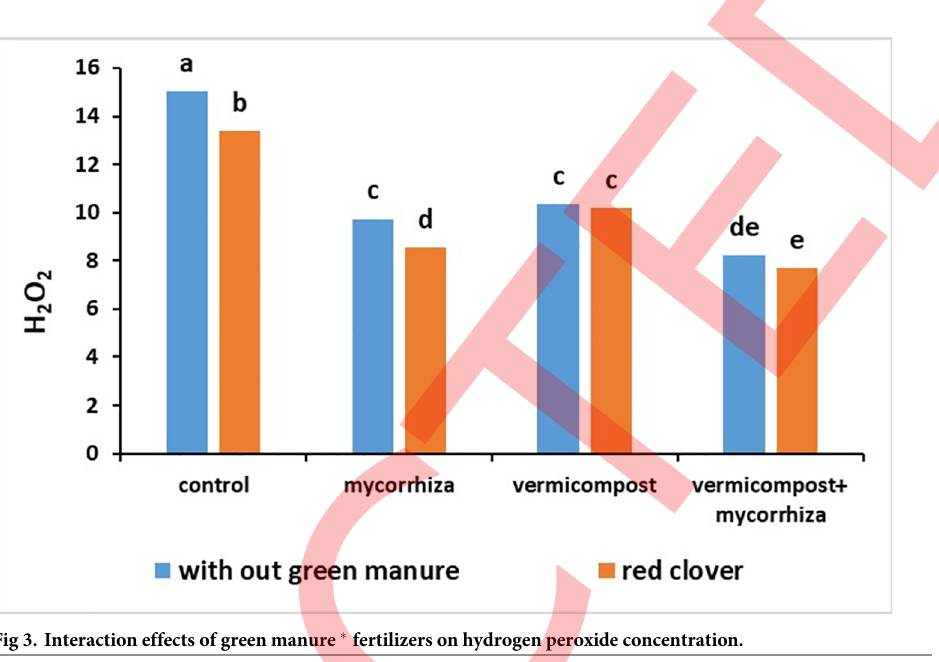
Fig 3. Interaction effects of green manure � fertilizers on hydrogen peroxide